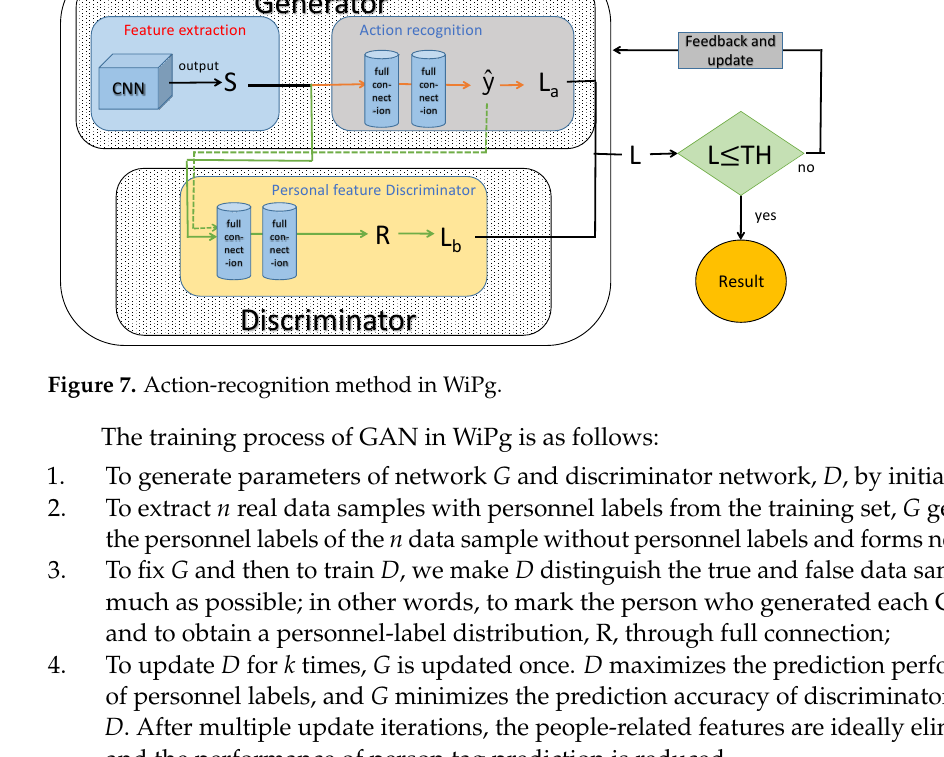
10 of 22 Figure 6. POSE TWO ’ s FFT curve. The energy distribution in the frequency domain after FFT transformation is shown in Figure 6. It can be seen that after normalized FFT conversion, there are two large peak signals, namely the 6 Hz signal and the 10 Hz signal. This segment of signal is the dynamic frequency variation range caused by POSE TWO. The frequency variation caused by DC signal is not recorded in the frequency variation range caused by the action. The FFT peak value of the blue circle in Figure 6 is lower than 1, which is considered to be the control- lable signal caused by POSE TWO and is not recorded as the frequency range caused by the action. Therefore, we can use the signals between the two larger peaks to ensure that CSI can be collected effectively when the action occurs. This will be of great help to the subsequent feature extraction.